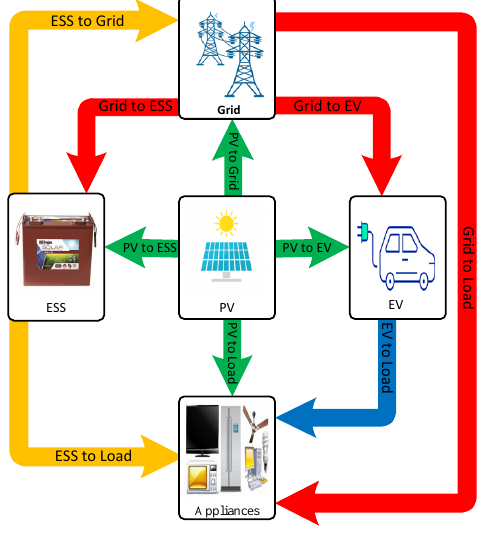
Figure 2. Energy exchange paths between components of the smart